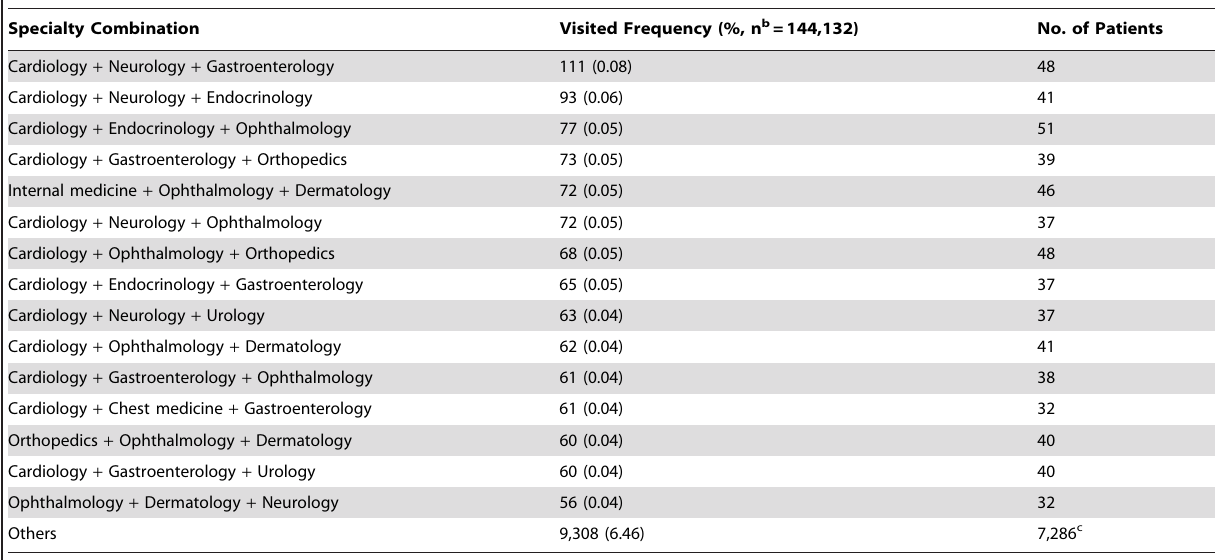
Table 5. Patterns of three-specialty combinations in one-stop visits a in 2005